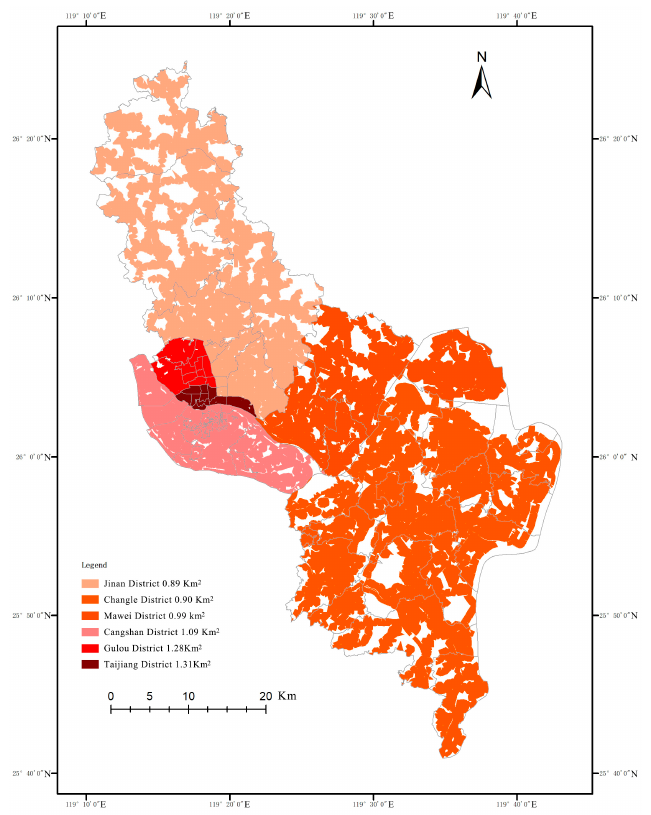
Figure 10. Accessible area in Fuzhou